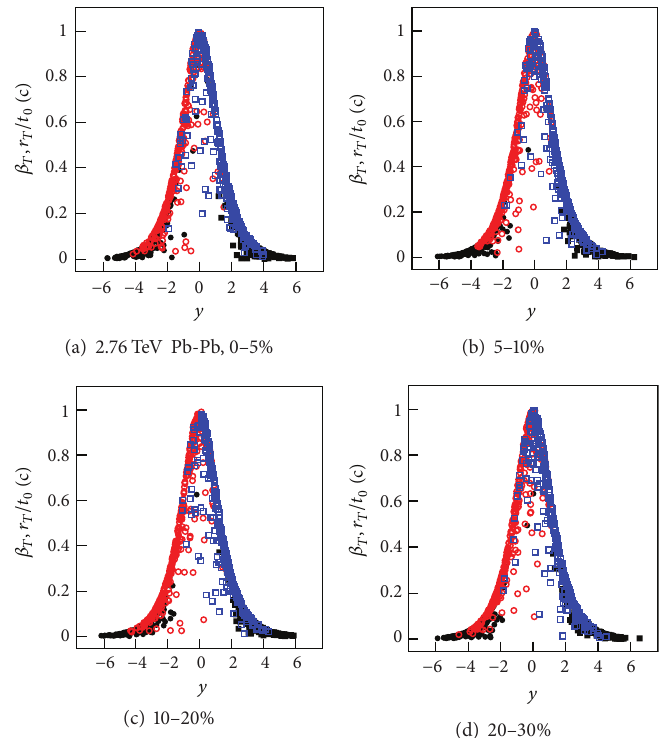
Figure 12: The same as for Figure 4, but showing the results in the space 𝛽 𝑇 − 𝑦 (or 𝑟 𝑇 /𝑡 0 − 𝑦